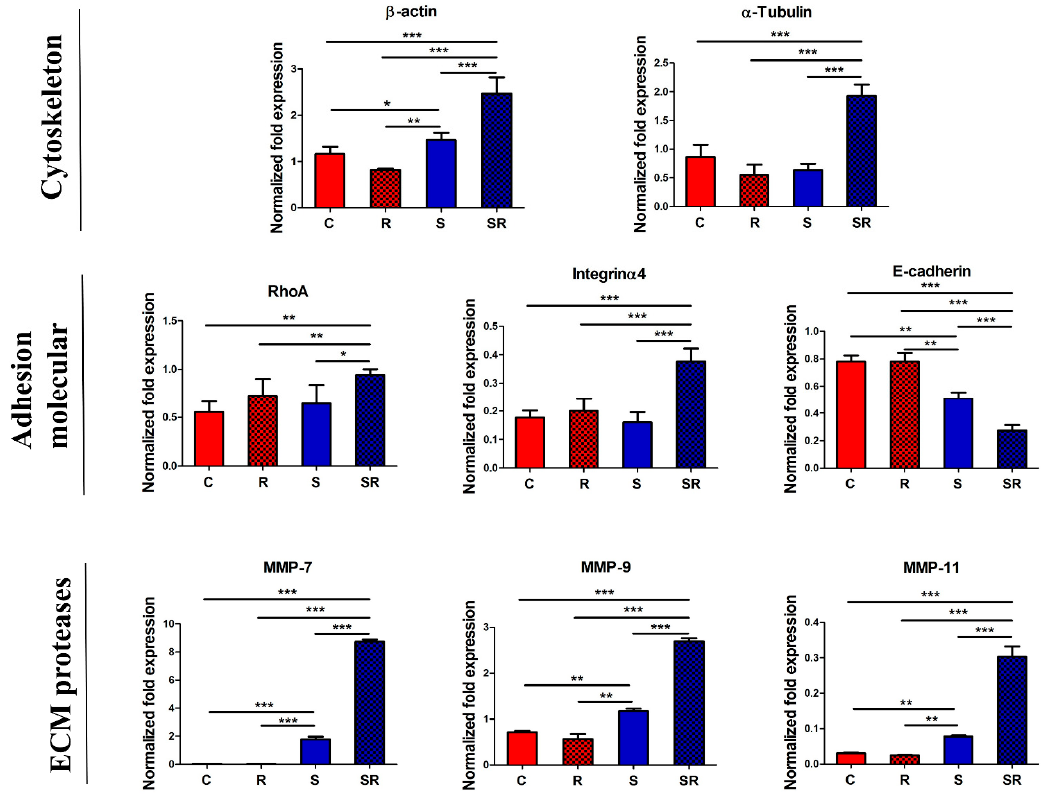
Figure 3. Quantitative real-time PCR validation of the high-throughput sequencing data. The verified genes belonged to the metastasis-related factors including cytoskeleton, adhesion molecule, and ECM proteases. The expression levels of all the selected genes were analyzed by transcriptomics, and confirmed by real-time PCR. Data represent the means ± S.D. of three independent experiments. Expression levels were compared between treated and non-treated groups. C, Control; R, Radiation; S, starvation; SR, starvation + radiation.* p < 0.01, ** p < 0.001, *** p < 0.0001.